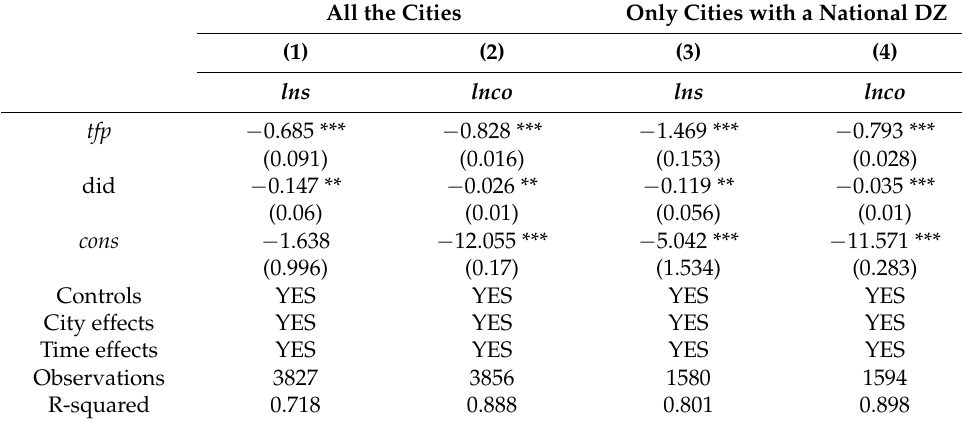
Table 13. Intermediary